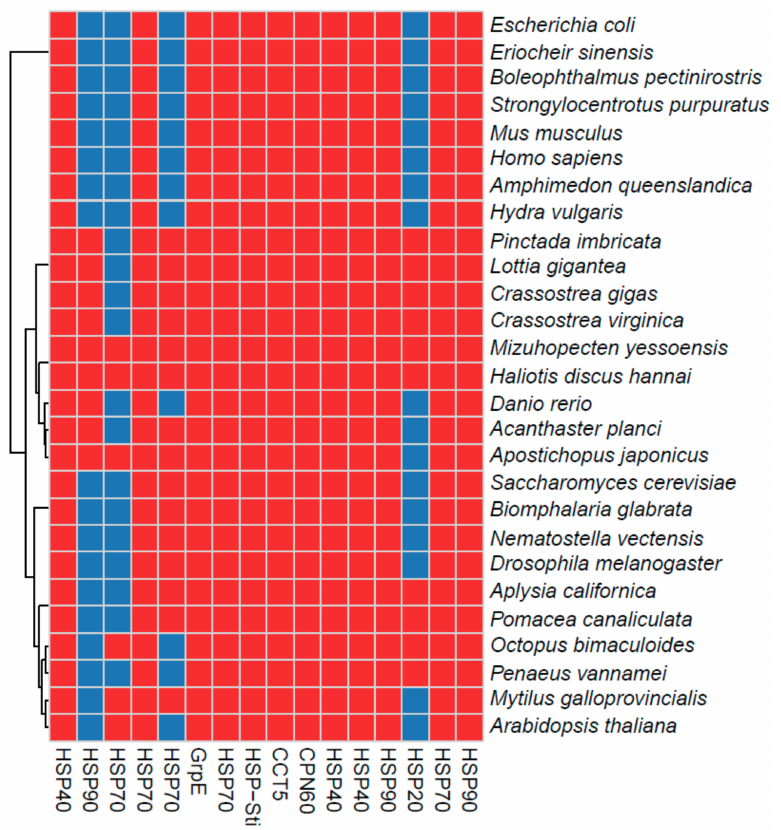
Figure 4. Di ff erentially expressed HSPs in H. discuss hannai and comparative profiles with other shellfish inhabiting intertidal zones, as well as humans, plants, insects, yeast, and bacteria. Red and blue denote the presence of discus hannai and absence of the homologous proteins, respectively. The binary values were obtained using the orthoMCL